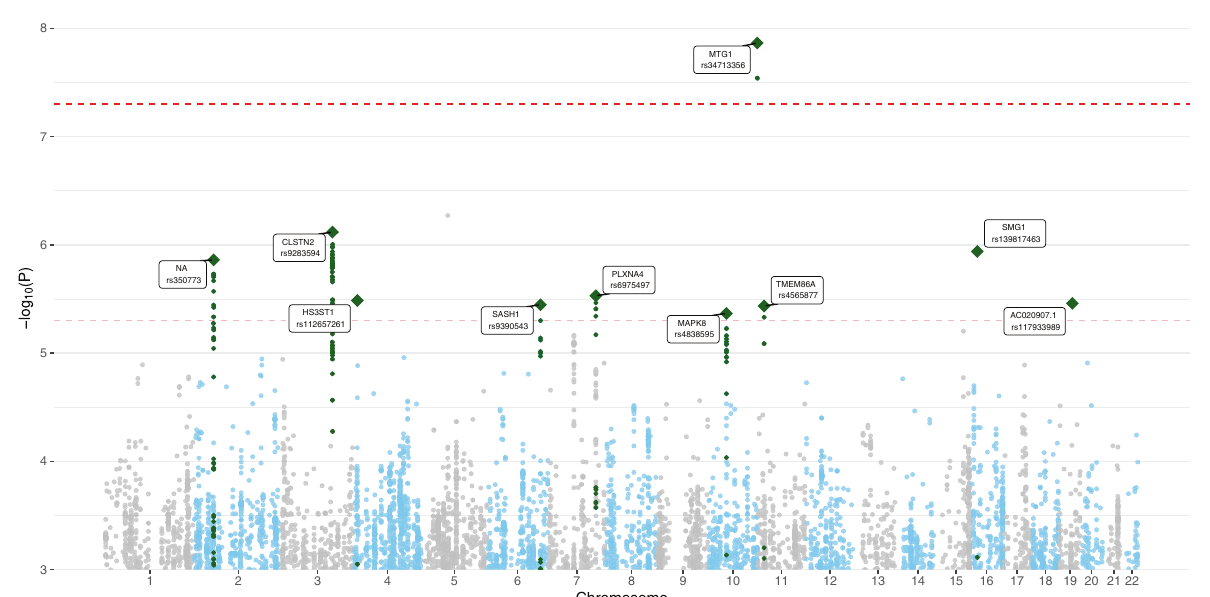
Fig. 1 Manhattan plot from the GWAS of PTSD cases in the CCSS cohort, showing the top variants in 10 independent risk loci. CCSS Childhood Cancer Survivor Study, GWAS genome-wide association study, PTSD posttraumatic stress disorder. This analysis included 671 cases and 3313 controls. Single-nucleotide polymorphisms in green are in linkage disequilibrium ( r 2 < 0.1) with the index single-nucleotide polymorphisms (diamonds) and have a P -value < 0.001. Index variants located with a distance less than 400 kilobase are considered as 1 locus. The model was adjusted for sex and top 10 principal components. The point estimates are provided in Table 2 and Supplementary Table